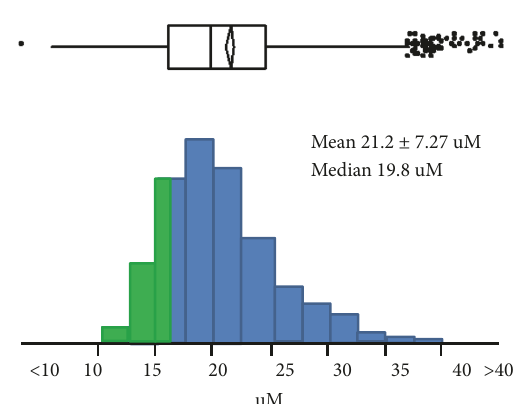
Figure 1: Distribution of AAT levels (uM) among MZ AATD individuals. Those in the lower quartile (less than or equal to 16uM) were included in this